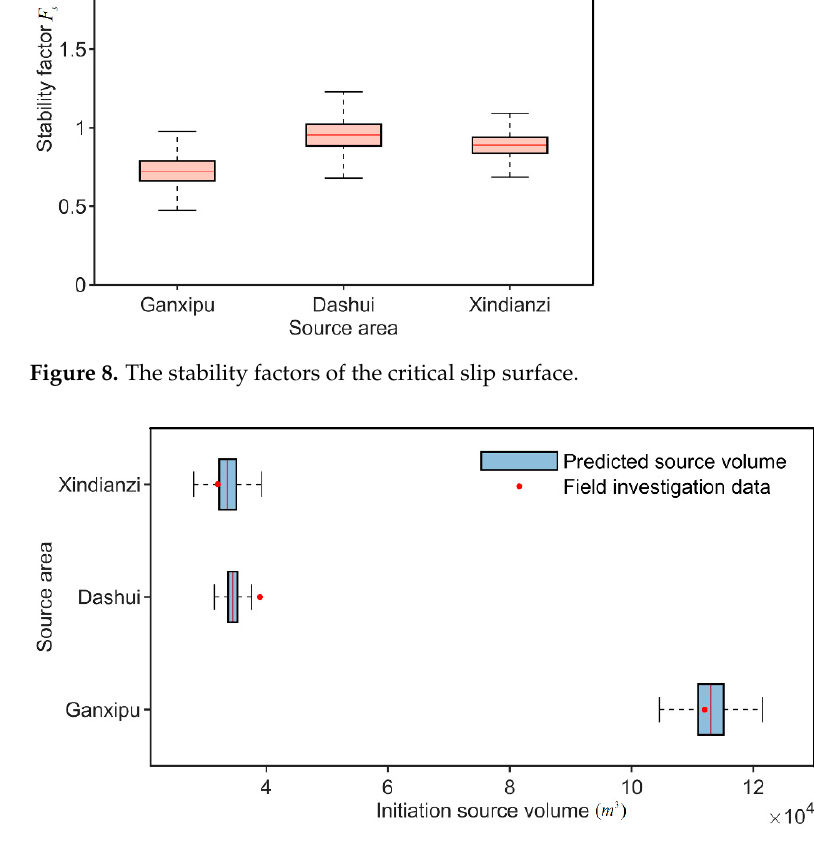
Figure 9. The predicted range of initiation source volume.